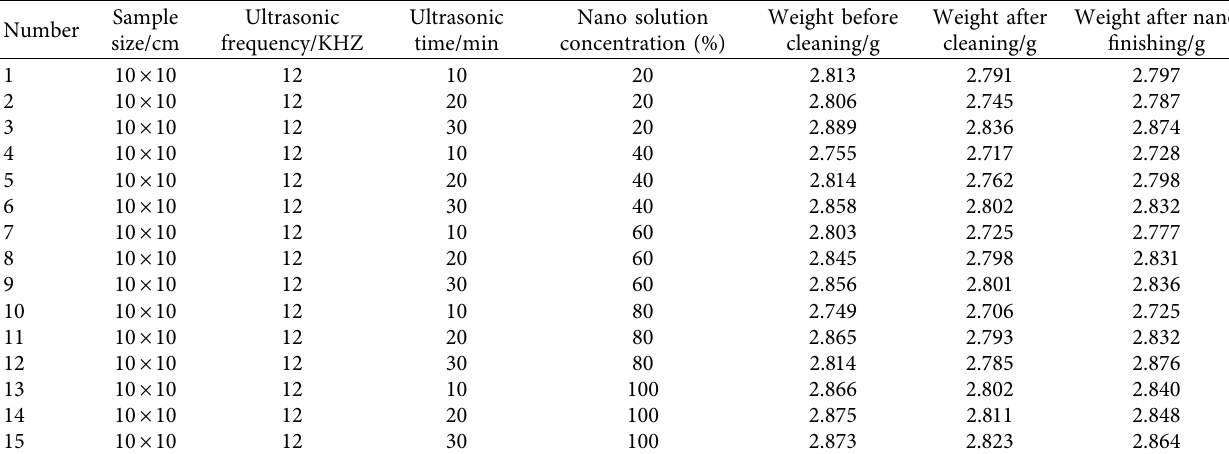
Table 3: Specimen weight change data